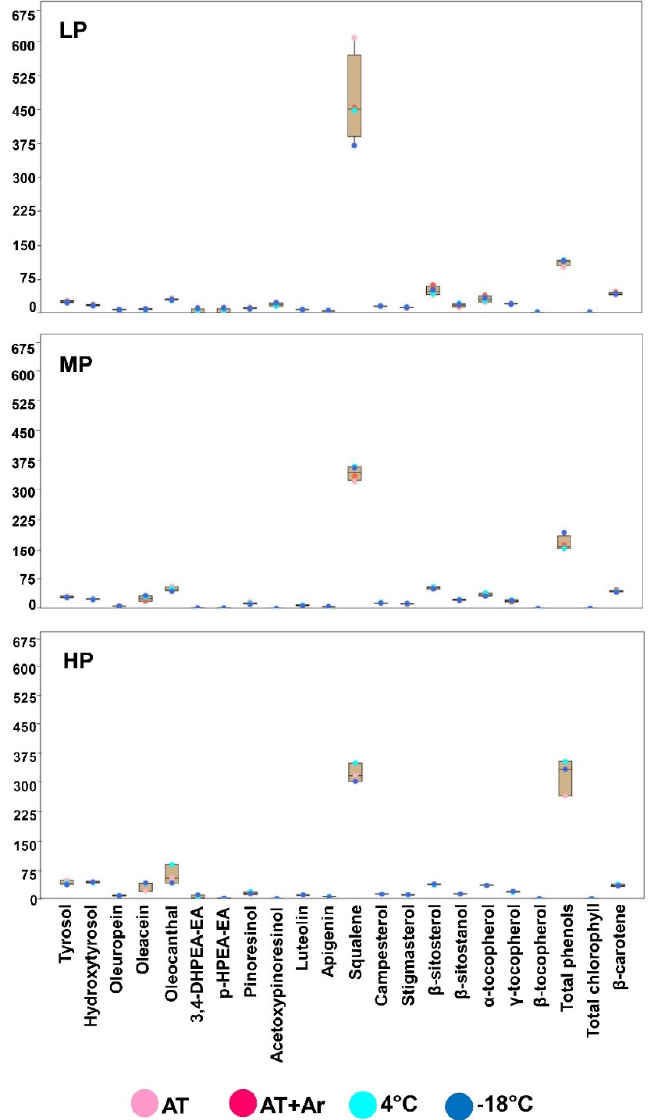
Figure 5. Box and jitter plot representing significant differences in the concentration of twenty-two chemical parameters at 8 months after bottles’ opening (T18-8 m) under different conditions. Colored circles indicate the different storage conditions; pink: AT; dark pink: AT + Ar; light blue: 4 °C; and dark blue: − 18 °C.